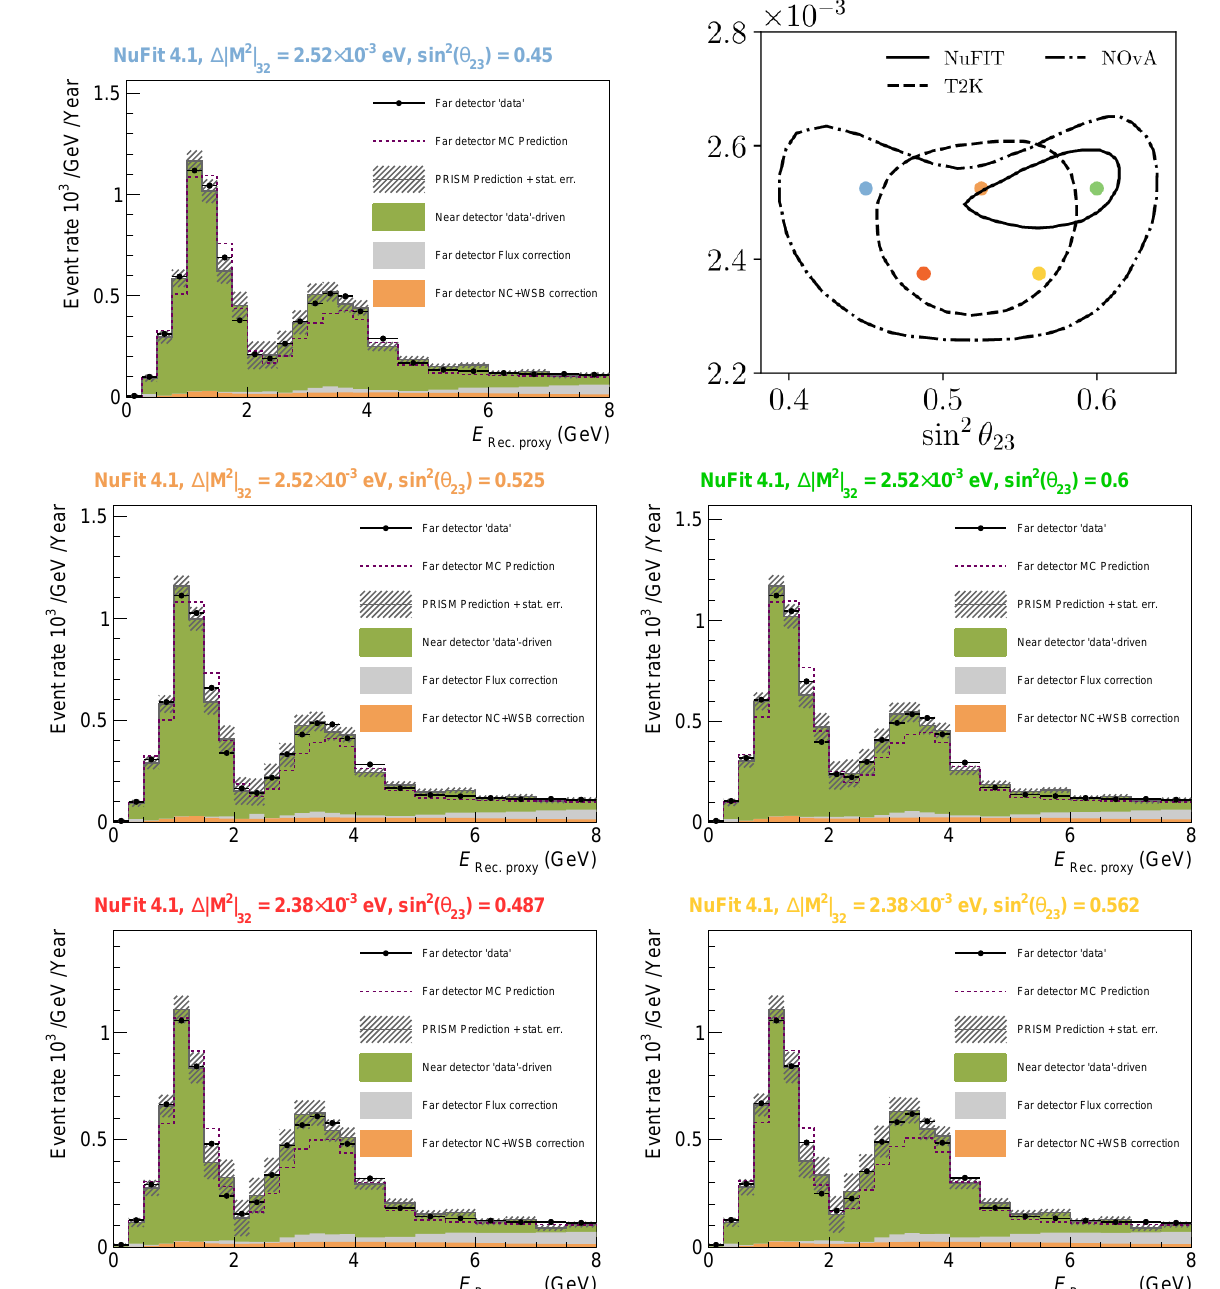
Figure 114. The DUNE-PRISM muon neutrino FD prediction for a range of disappearance hypotheses. The hypothesis used is noted above each sub-figure and compared to the world data in the top right sub-figure. The ‘data’ used in each of these figures is the missing proton energy mock dataset. For each prediction: the linear combination of ND ‘data’ measurements is shown in green; the FD simulation correction that accounts for the imperfect flux match is shown in gray; the predicted FD ‘data’ is shown as black points; and the FD simulation is shown in dark red. The statistical uncertainties on the PRISM predicion are shown, these are determined from the MC sample size at the ND, and are large due to a lack of ND MC. It can be seen that the GENIE-based FD prediction (dark red) is a poor predictor for the FD data, whereas the linear combination of ND data correctly predicts the FD spectrum, despite the presence of an unknown cross section modeling problem in both the near and FD